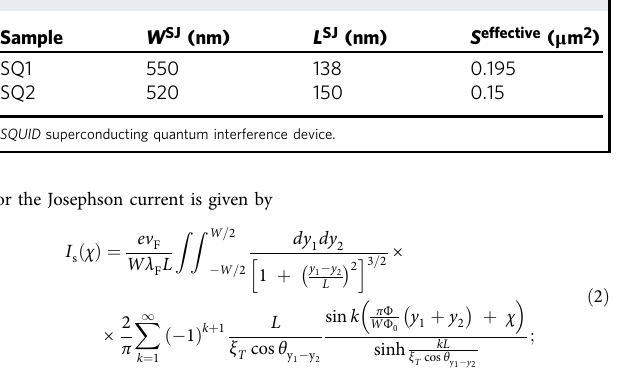
Table 5 Fitting parameters for SQUIDs, where W SJ and L SJ are width and length of Josephson junction playing the role of an envelope and S effective is a square of SQUID itself.